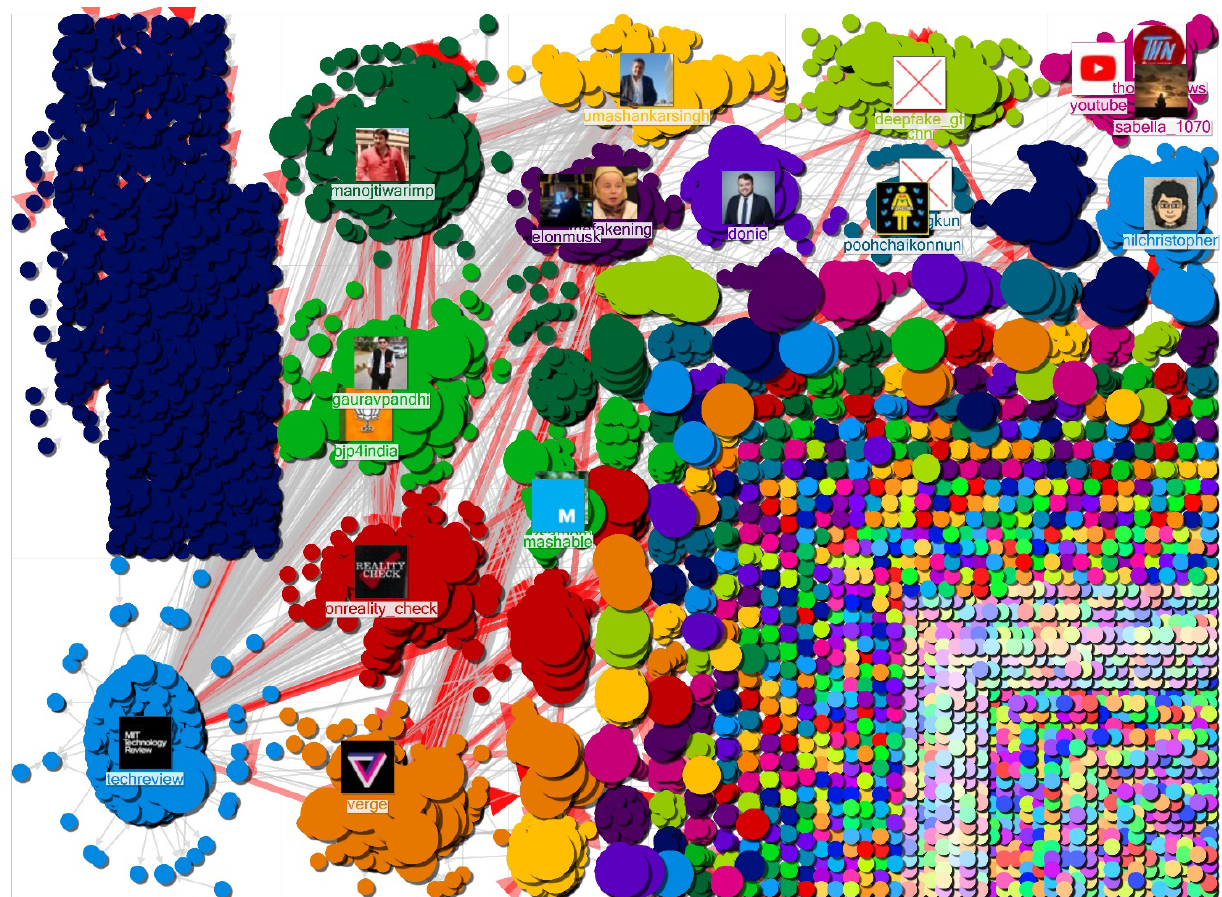
Figure 4. Illustration of the main actors control the flow of information on the network.